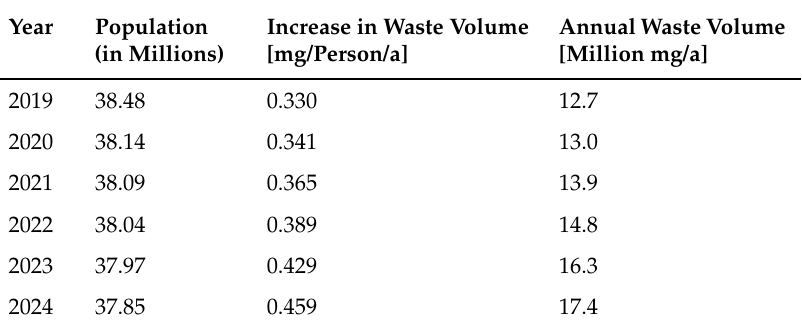
Table 5. Trend extrapolation of the volume of municipal waste in